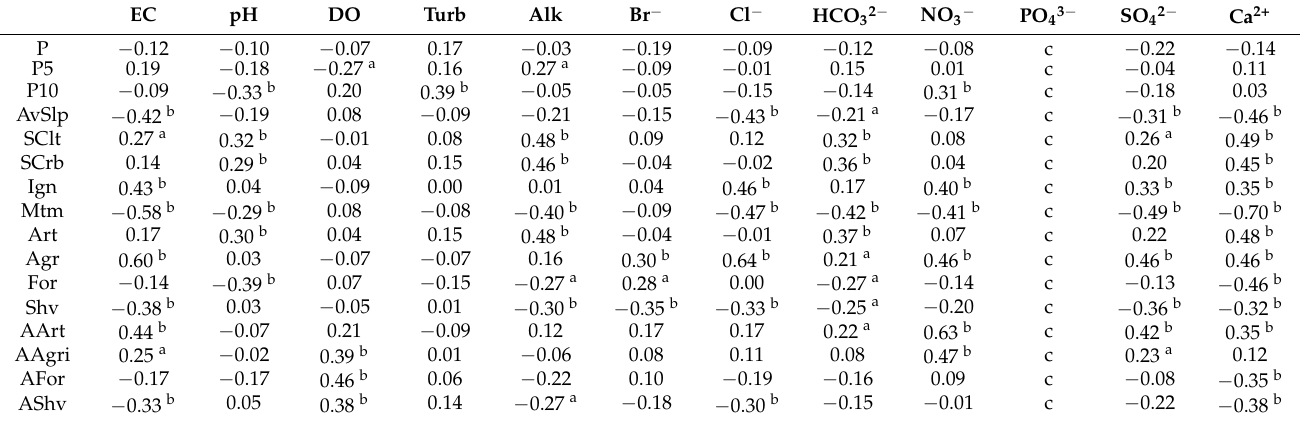
Table 4. Pearson correlation coefficients between the studied influences and water quality